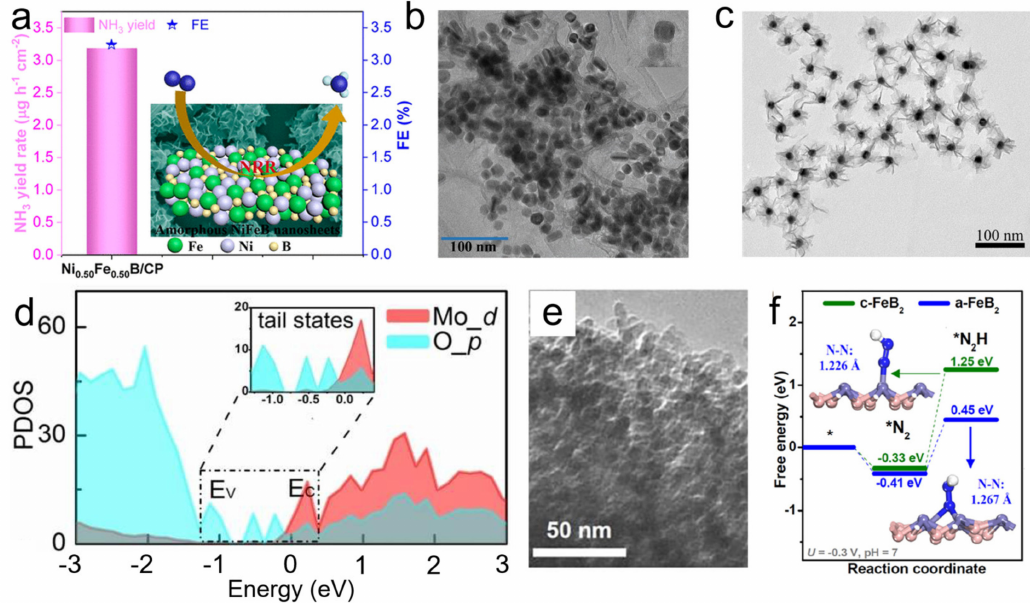
Figure 7. ( a ) Schematic diagram of NRR on amorphous NiFeB nanosheets. Reprinted with permission from Ref.